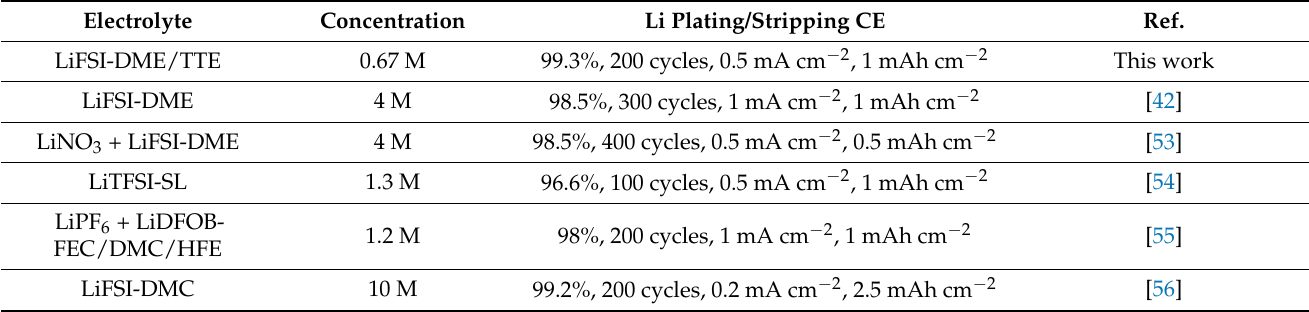
Table 1. Electrochemical performance of LMBs in various electrolytes. Electrolyte Concentration